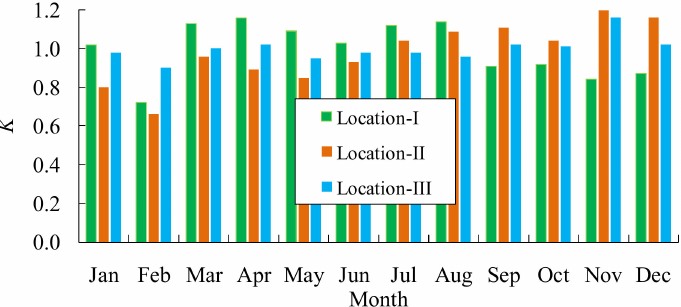
Figure 11. Traffic volume distribution of each month in